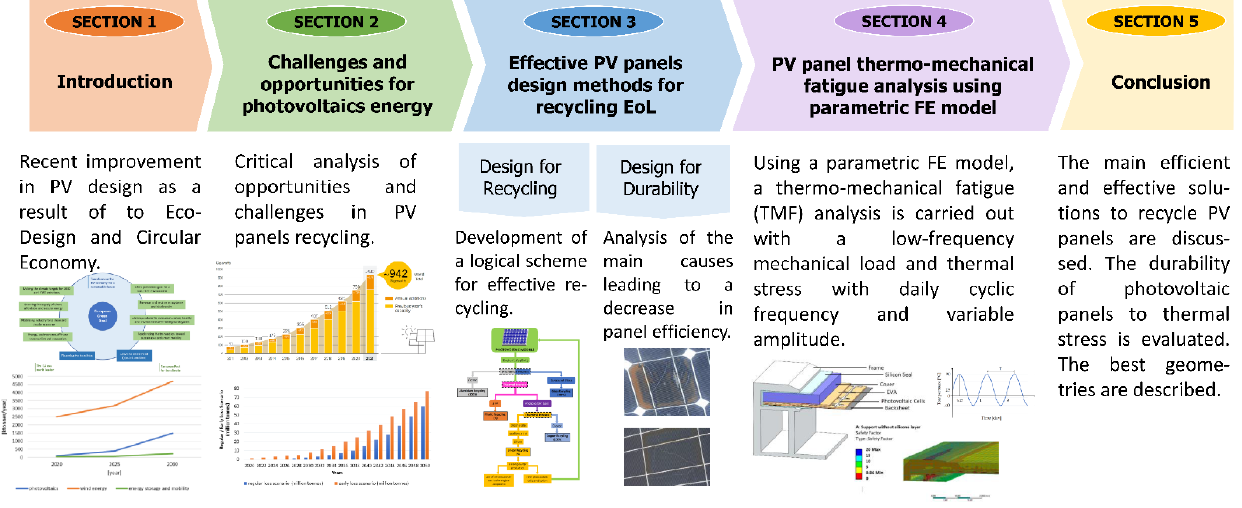
Figure 3. Main research steps.